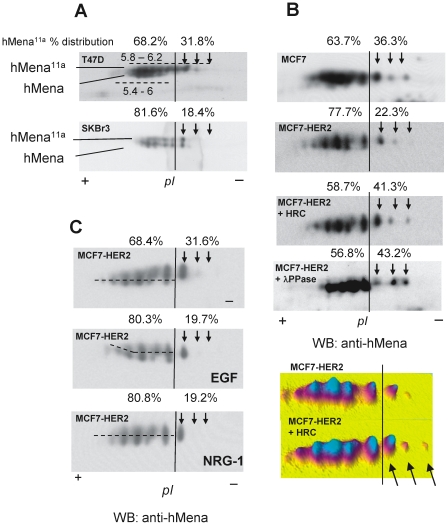
HER2 overexpression affects hMena11a phosphorylation in breast cancer cells.
A. Proteins from T47D and SKBr3 cell lines were resolved by 2D-electrophoresis on a pH 3–10 nonlinear range and 7.5% acrylamide SDS-PAGE. Proteins were then electrontransferred to nitrocellulose and hMena reactivity was revealed by Western blot. Protein spot trains were compared by using Progenesis PG240 v2006 software (Nonlinear dynamics, Newcastle, UK). The set of spots corresponding to hMena and hMena11a are indicated including the isoelectric point range (dashed line). The phosphorylation threshold (arrows and vertical bars) has been arbitrarily defined as described [13]. B. Lysates of MCF7 cells, either stably transfected with HER2 or with empty vector (pcDNA3) were resolved by 2D-electrophoresis as described above, showing that a higher fraction of hMena11a is constitutively phosphorylated in MCF7-HER2 cells. MCF7-HER2 cells treated with Herceptin for 48 h (MCF7-HER2+ HRC) show a fraction of phosphorylated hMena11a similar to the dephosphorylated MCF7-HER2 lysates. MCF7-HER2 cell lysates were also incubated without or with λ-phosphatase (λ-PPase) before 2D analysis. Arrows indicated hMena11a spots after phosphatase treatment. Below the densitometric analysis of the hMena spots revealed by Western blot in MCF7-HER2 cells treated without (- HRC) or with Herceptin for 48 h (+ HRC) are shown. Arrows indicated hMena11a spots that, after Herceptin treatment, resulted to be dephosphorylated. Pseudo-colours three-dimensional view has been obtained by using Progenesis PG240 v2006 software. C. Proteins from the MCF7-HER2 cell lines incubated with or without 100 ng/ml EGF or 10 ng/ml NRG1 for 24 h in serum starved medium, were resolved by 2D-electrophoresis and analyzed as described in panel A.